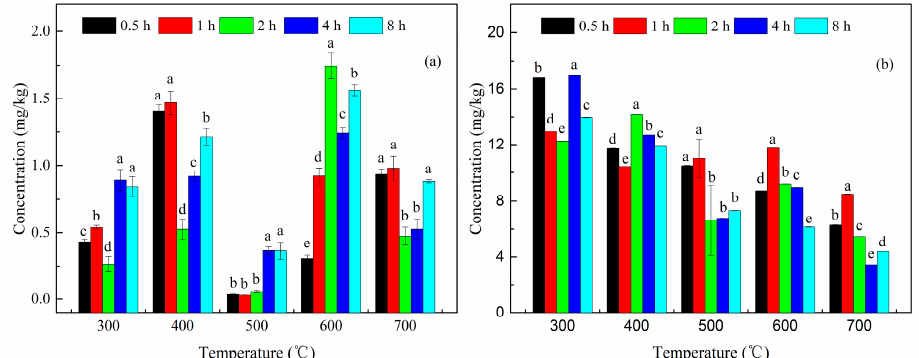
Figure 2. Effects of different temperatures and time on removal of naphthalene ( a ) and fluoranthene ( b ) in soils during calcination. Different letters indicate significant difference ( p ≤ 0.05) between treatments of different calcination time at the same temperature. Table 4. The removal efficiency (%) of naphthalene in soils by calcination technique. Temperature (°C)